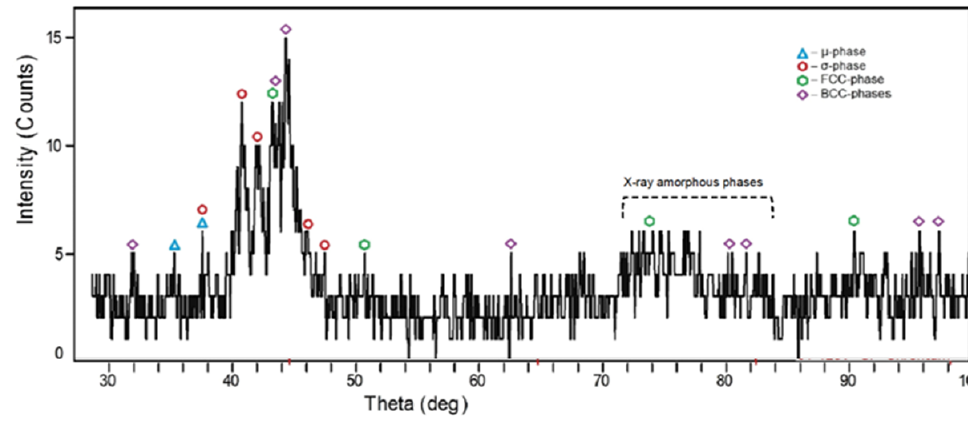
Figure 3. XRD pattern of sintered NiAl–CrMoCo matrix.